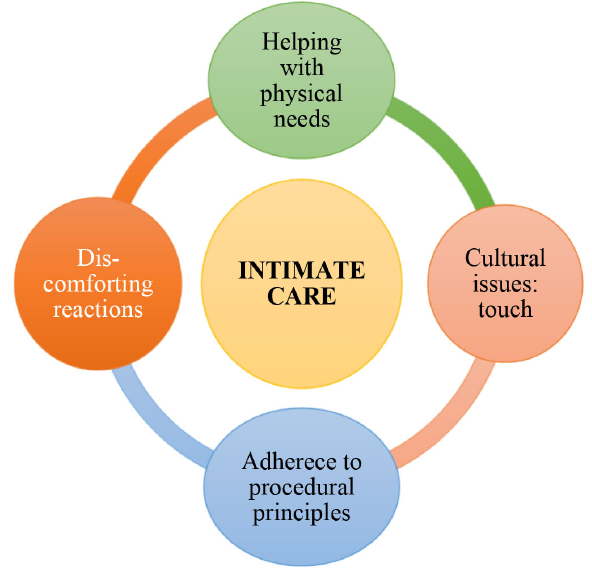
Fig. 1. Intimate care